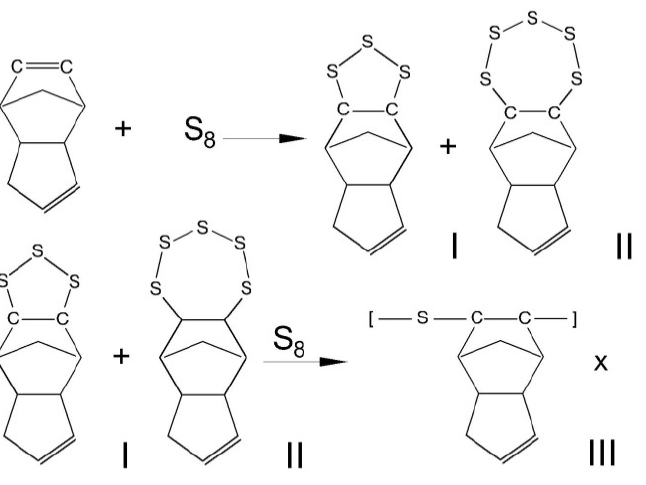
Figure 1. Chemical modification with dicyclopentadiene (2-column fitting image).